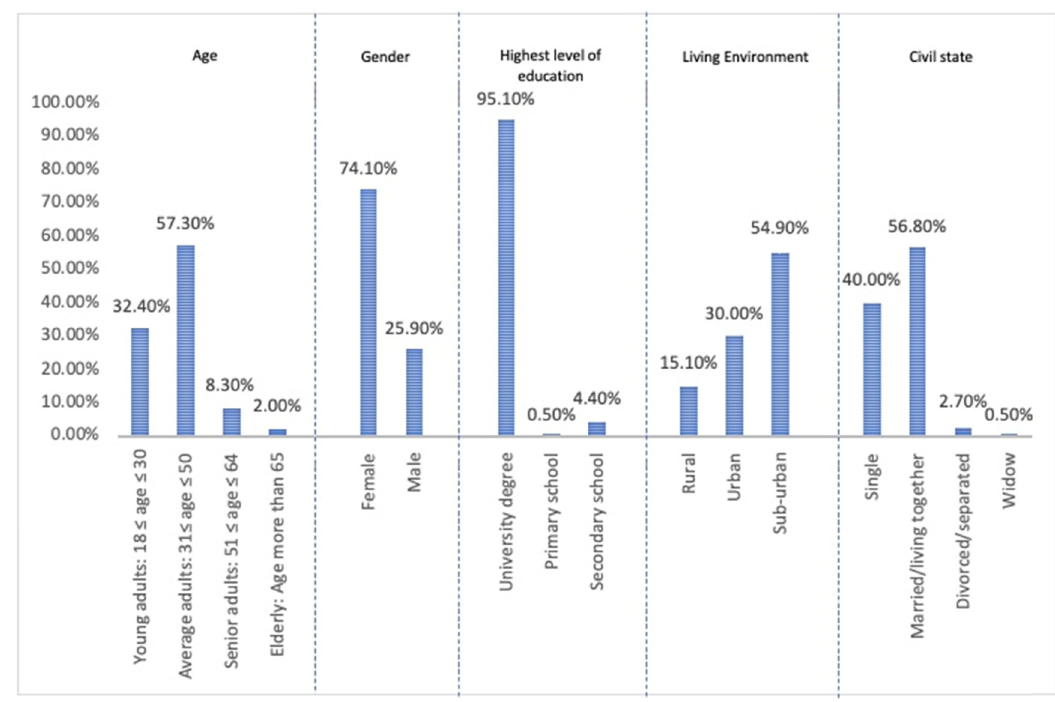
Figure 1: Demographical data: age, gender, highest level of education, living environment, civil